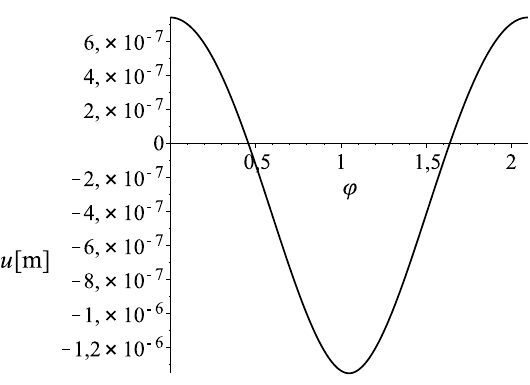
Figure 13: The plot of the radial displacement.